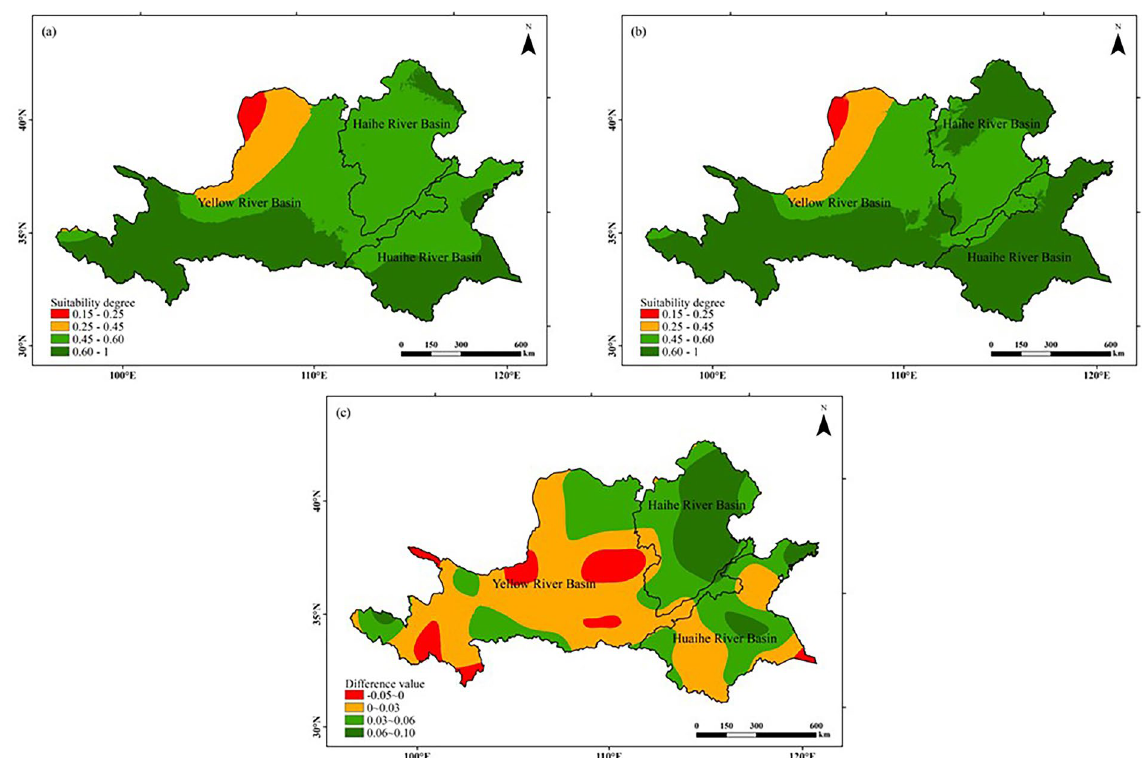
Figure 7. Comparison of distribution of precipitation suitability for peanut growing seasons in the Huang- Huai-Hai region in two climatic years: ( a ) 1960–1989, ( b ) 1990–2019, ( c ) ( b )–( a ). The figure was made in the ArcGIS 10.2 platform (https:// www. esri. com/ en- us/